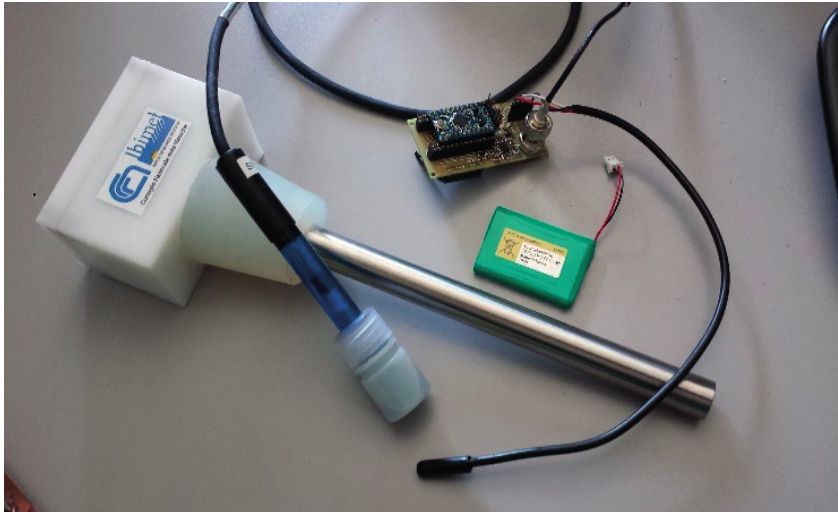
Figure 3 . WineDuino node with sensor and